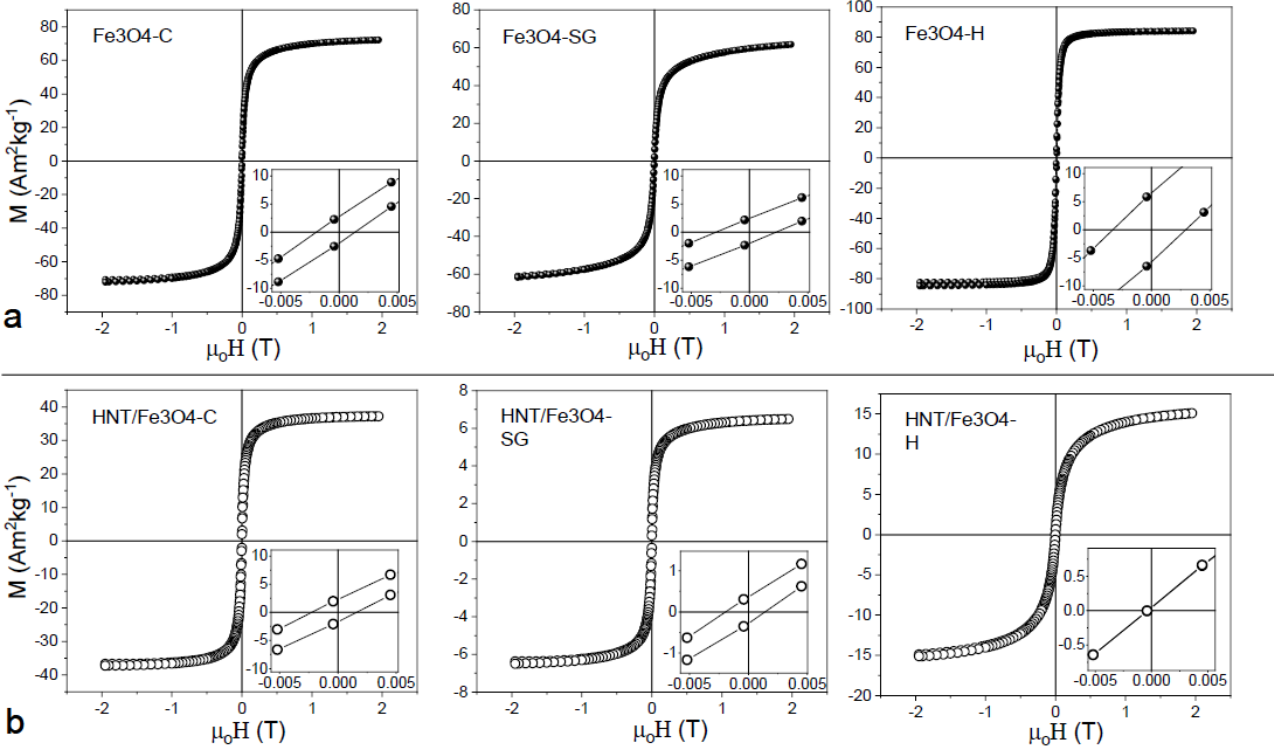
Figure 6. Field dependence of magnetization at 300 K for the ( a ) bare Fe 3 O 4 nanoparticles synthetized by coprecipitation (Fe 3 O 4 -C) sol-gel (Fe 3 O 4 -SG) and hydrothermal methods (Fe 3 O 4 -H) and ( b ) HNTs/Fe 3 O 4 nanocomposites. The insets are zoom of the coercive field region.